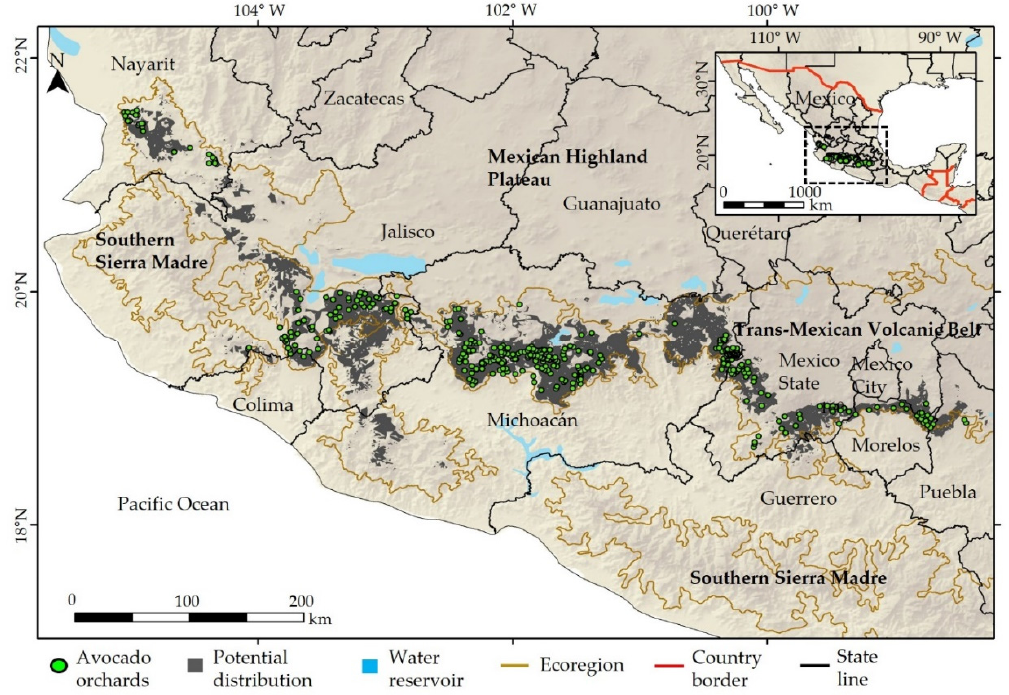
Figure 1. The presence points of Hass avocado orchards and potential distribution of Persea americana Mill. in central Mexico.